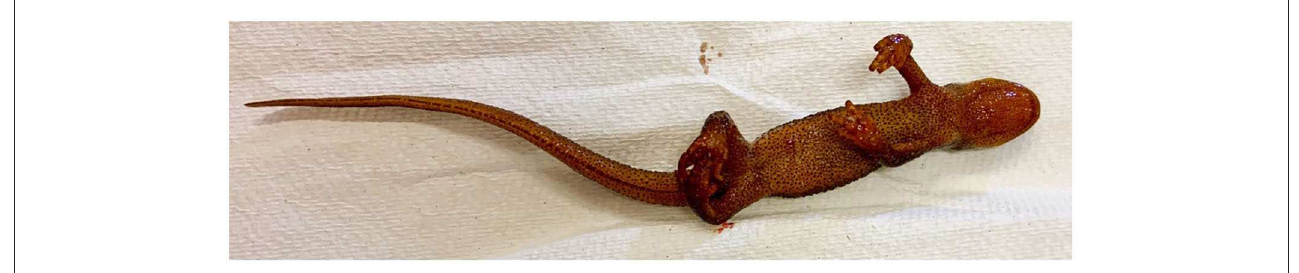
FIGURE3 Taricha granulosa with multiple, characteristic erosive to ulcerative Batrachochytrium salamandrivorans induced skin lesions (TW14).